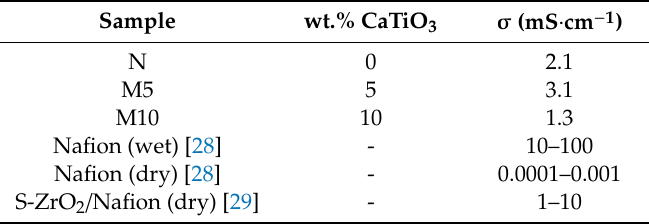
Table 2. Conductivity values ( σ ) measured for different membranes at 110 °C.